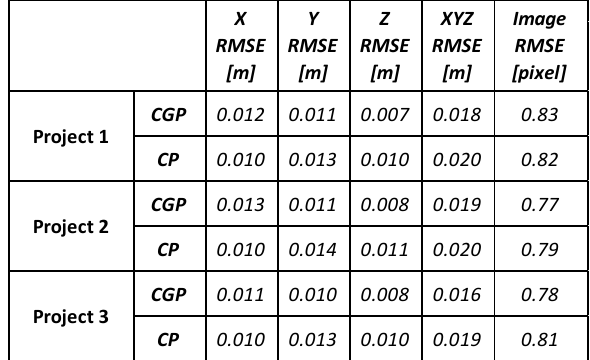
Table 8. Results of RPAS image orientation using the three different camera calibration